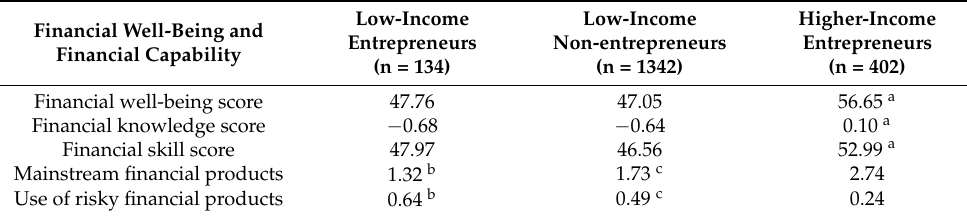
Table 3. Financial well-being and financial capability (N =